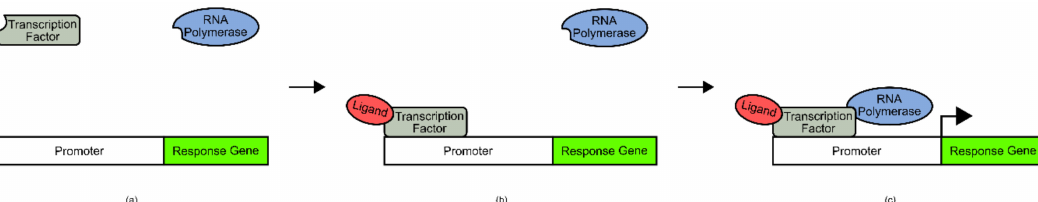
Figure 1. Transcription factor biosensor configuration. A known transcription factor protein that is regulated by a ligand of interest can be used to target a cognate promoter sequence that is used to initiate transcription of a response gene such as GFP or antibiotic resistance: ( a ) In the absence of ligand binding to the transcription factor, there is little or no recruitment of RNA polymerase to the promoter site; ( b ) When ligand is present at a concentration sufficient to bind transcription factor proteins, the transcription factor becomes localized to the promoter; ( c ) Recruitment of RNA polymerase then allows transcription of the response gene (e.g., GFP or antibiotic